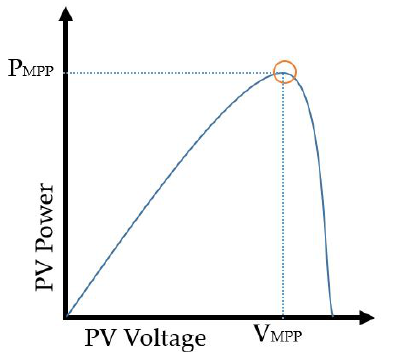
Figure 1. Maximum power point